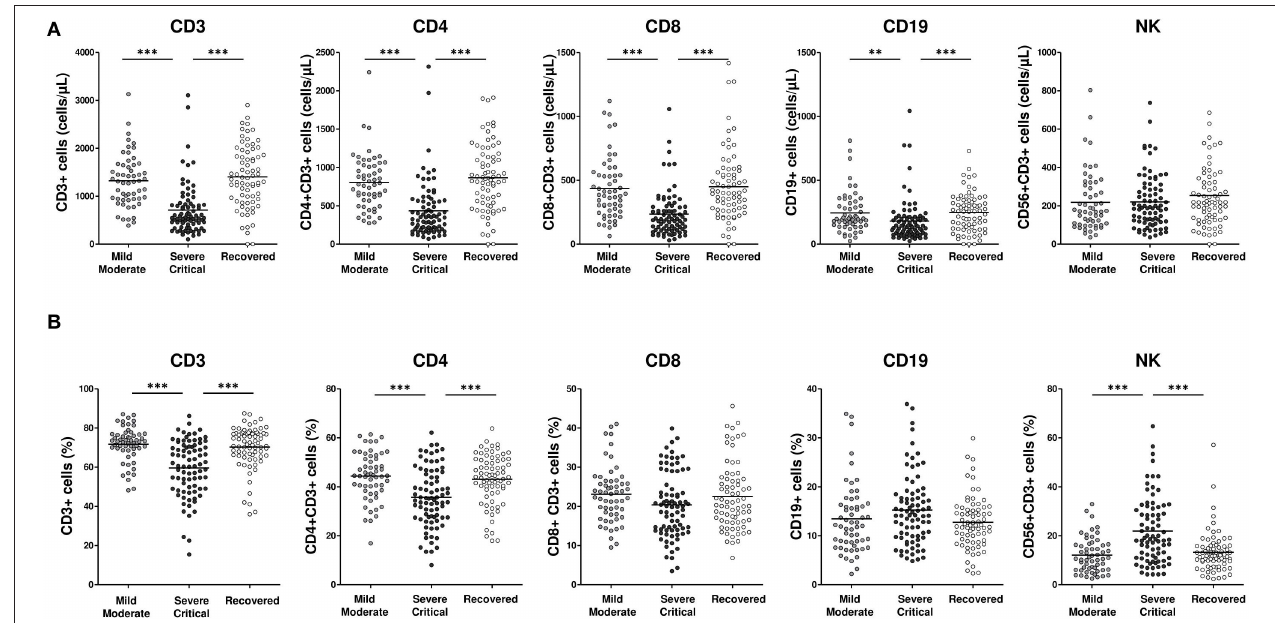
FIGURE 1 | Lower lymphocytes absolute number and frequency and higher NK frequency in severe/critical COVID-19 patients. Absolute numbers (A) and frequency (B) of peripheral blood cell populations (CD3, CD4, CDS, CD19 and NK) in mild/moderate (light gray circles), severe/critical (dark gray circles) and recovered (white circles) groups of patients. Each dot represents an individual patient. Data are given as mean (Kruskal–Wallis test P- values: ** P < 0.01; *** P < 0.001).